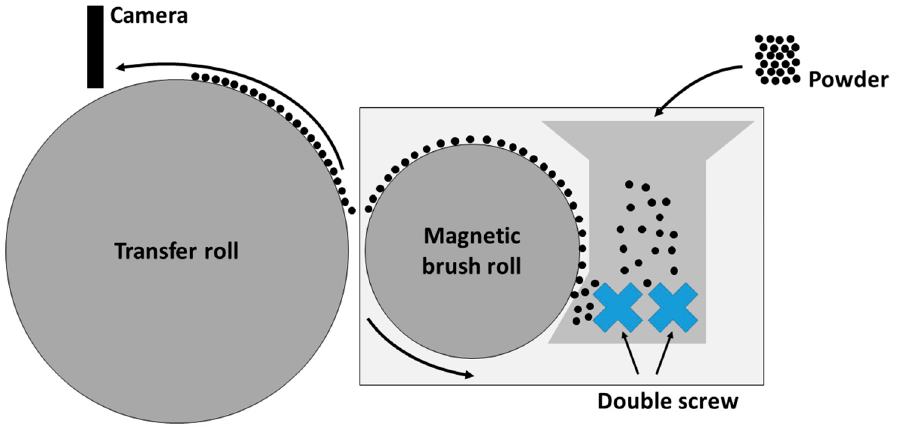
Figure 1. Experimental setup for the analysis of electrophotographic powder deposition (according to [49]).